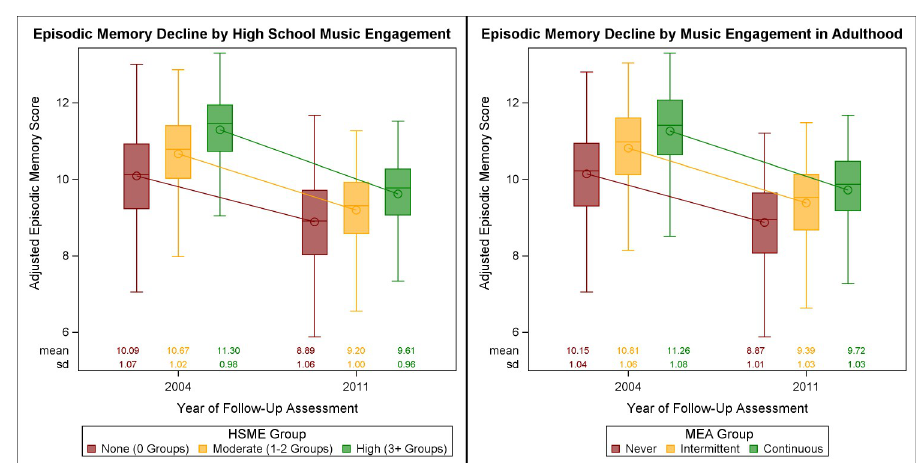
Fig 2. Change in adjusted episodic memory scores for musical engagement groups. ( A ) Adjusted predicted memory scores for high school musical engagement (HSME) groups are plotted at both time points. There were significant differences in the adjusted scores between High HSME group and the No HSME group at baseline ( B = 0.348, p = 0.049). Slopes between these groups also significantly differed, indicating a steeper rate of decline for the High HSME group compared to the No HSME group ( B = -0.435, p = 0.049). (B) Adjusted predicted memory scores for musical engagement in adulthood (MEA) groups are plotted at both time points. There were significant differences in the adjusted scores between the Continuous MEA group and the No MEA group at baseline ( B = 0.424, p = 0.012). Rate of decline (slopes) did not differ between the